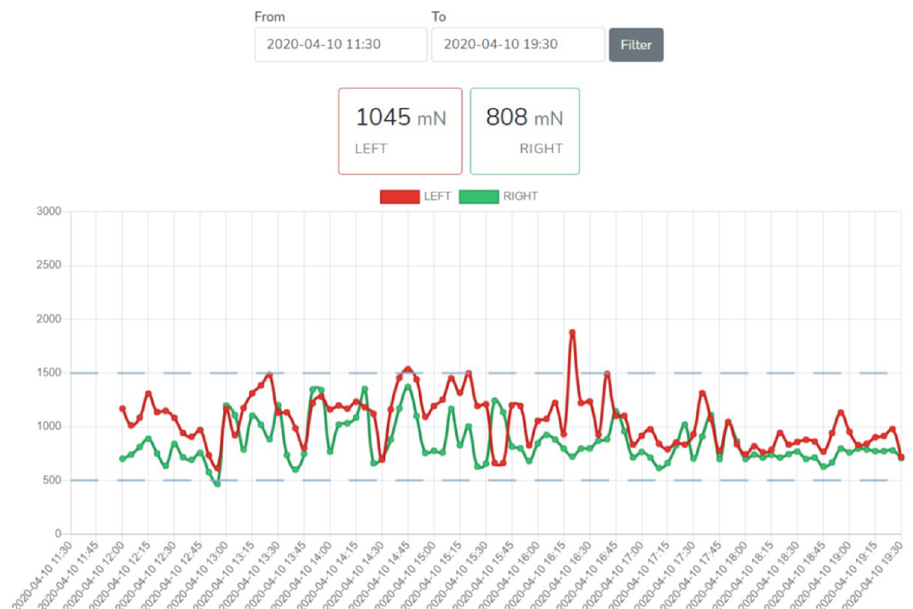
Figure 6. Cloud server view on computer screen (subject